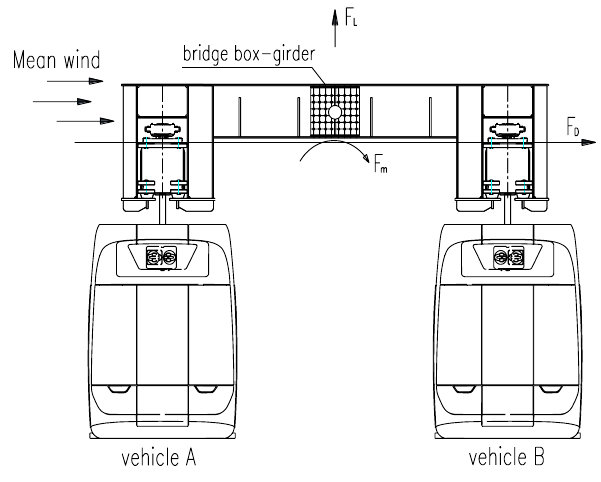
Fig. 4 Three coefficients of mean wind